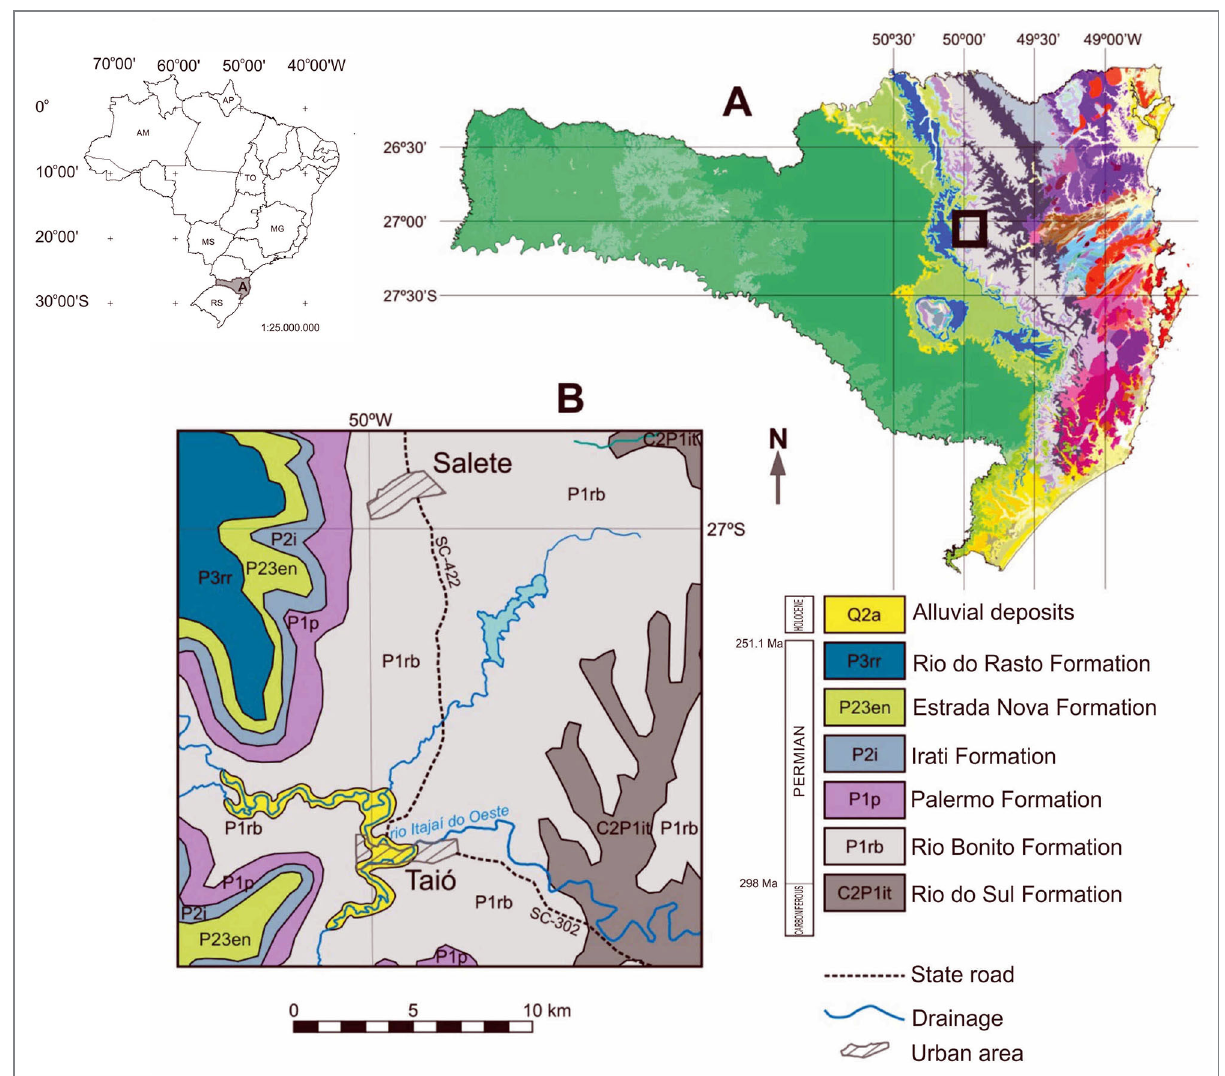
FIGURE 1 – Location of the study area, A) Geological Map of Santa Catarina (modified by Silva and Bortoluzzi 1987); B) Geology detail of the